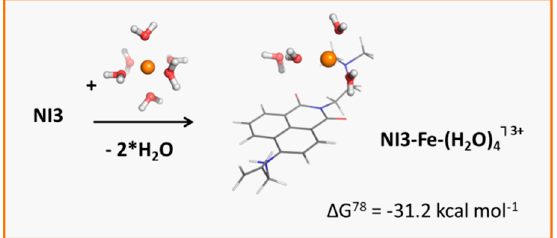
Figure 13. Modeled reaction between NI3 and hydrated Fe 3+ ions. The free energies Δ G 78 (in kcal mol − 1 ) Figure13. ModeledreactionbetweenNI3andhydratedFe 3 + ions. Thefreeenergies ∆ G 78 (in kcal mol − 1 ) for the complex formation reactions are shown. for the complex formation reactions are